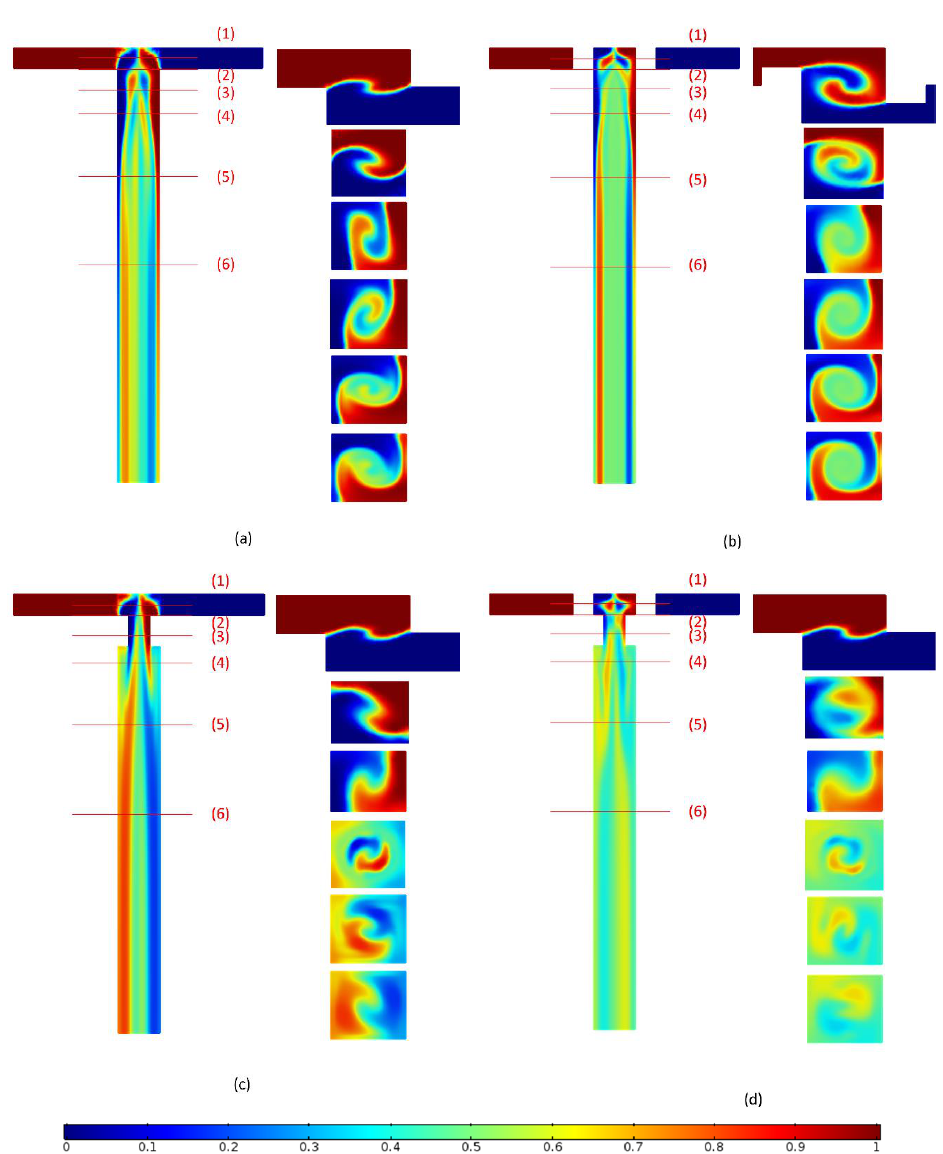
Figure 9. Concentration distribution at Re = 50 for ( a ) OTM, ( b ) TMSI, ( c ) TMRC, ( d ) TMSC. (1) x